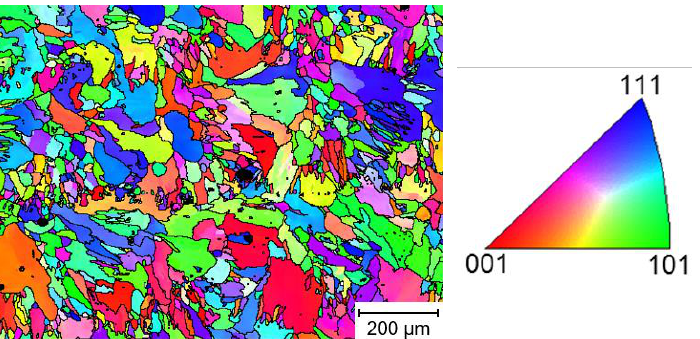
Figure 8. EBSD-IPF (inverse pole figure) micrograph of the LMD-manufactured HiperFer AM HPD